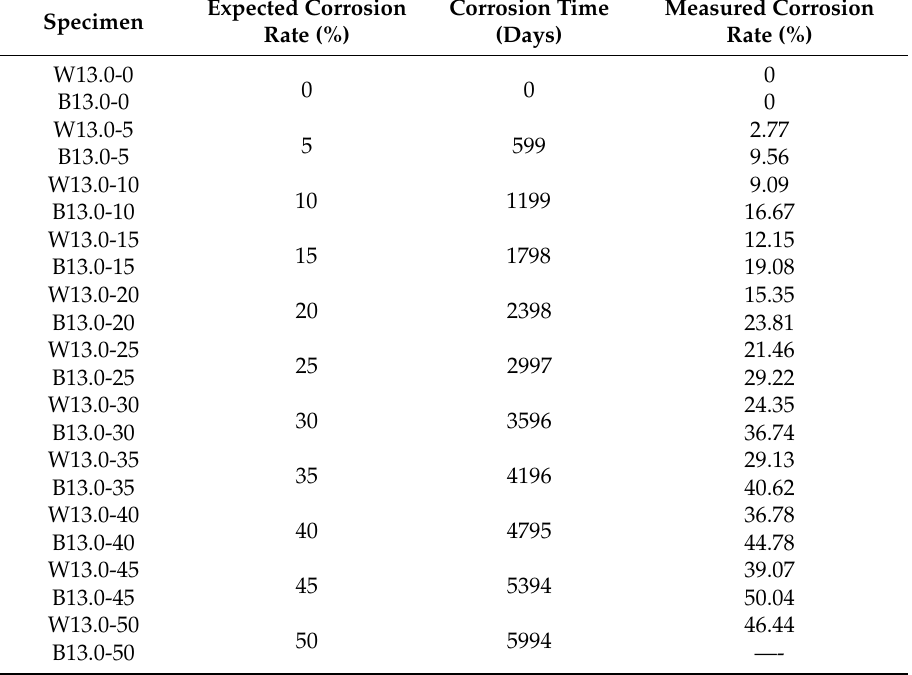
Table 4. Expected stud corrosion rate and actual corrosion time of the 13.0 mm